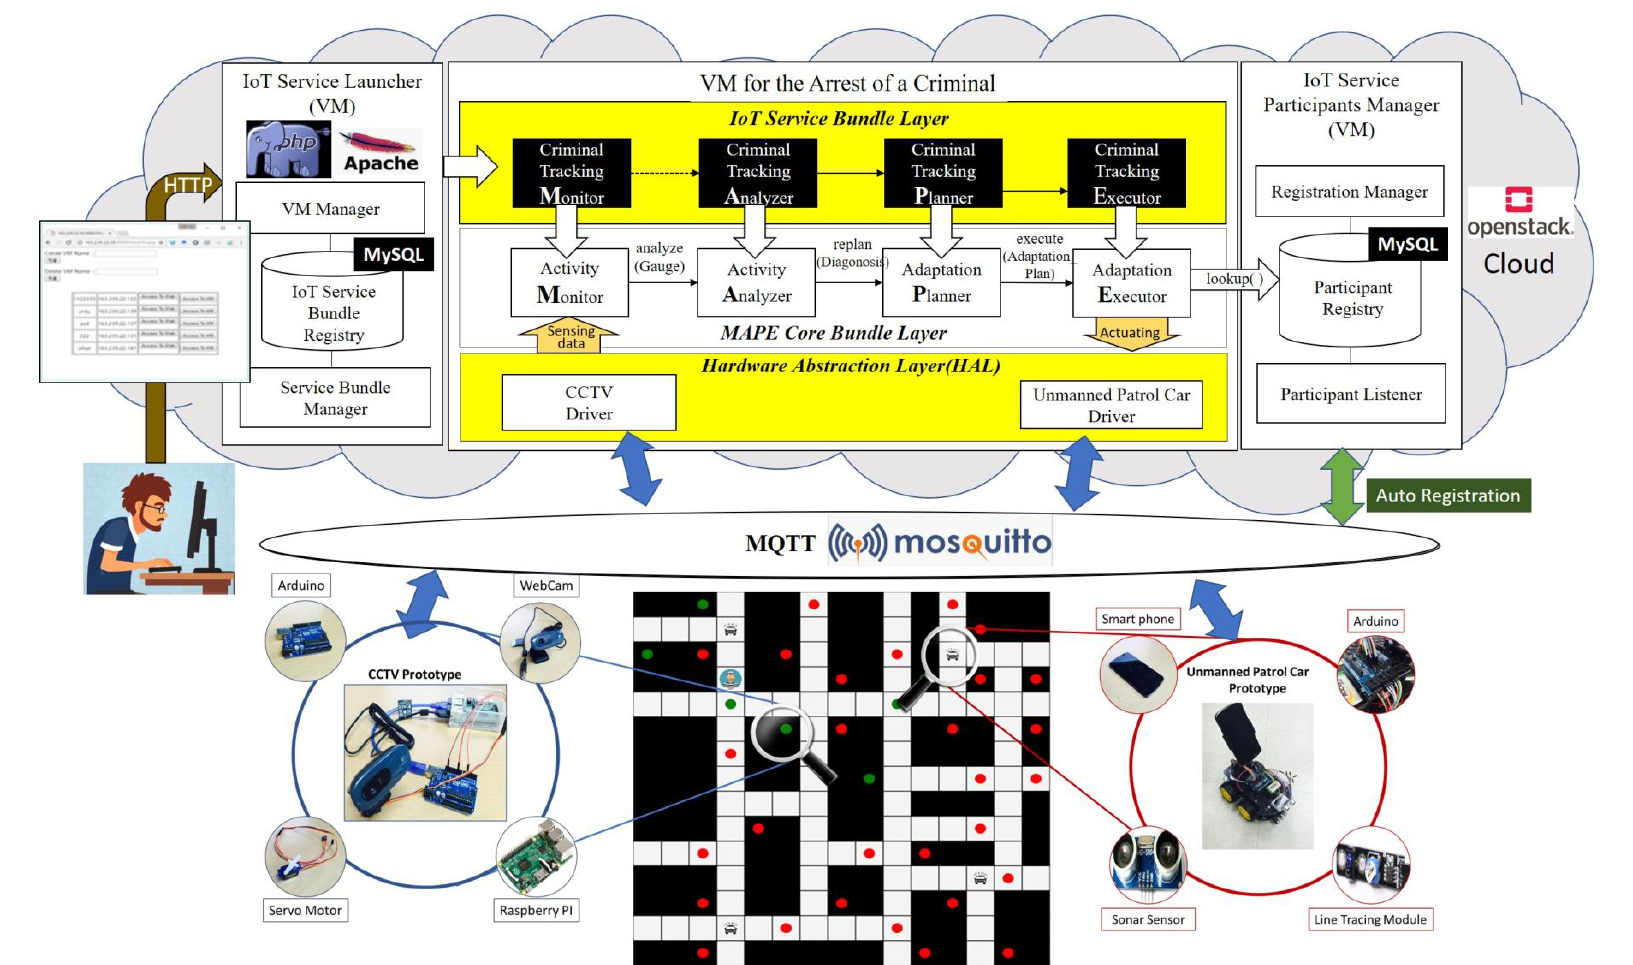
Figure 8. The constructed testbed of the collaboration for implementing the scenario for arresting a criminal suspect.